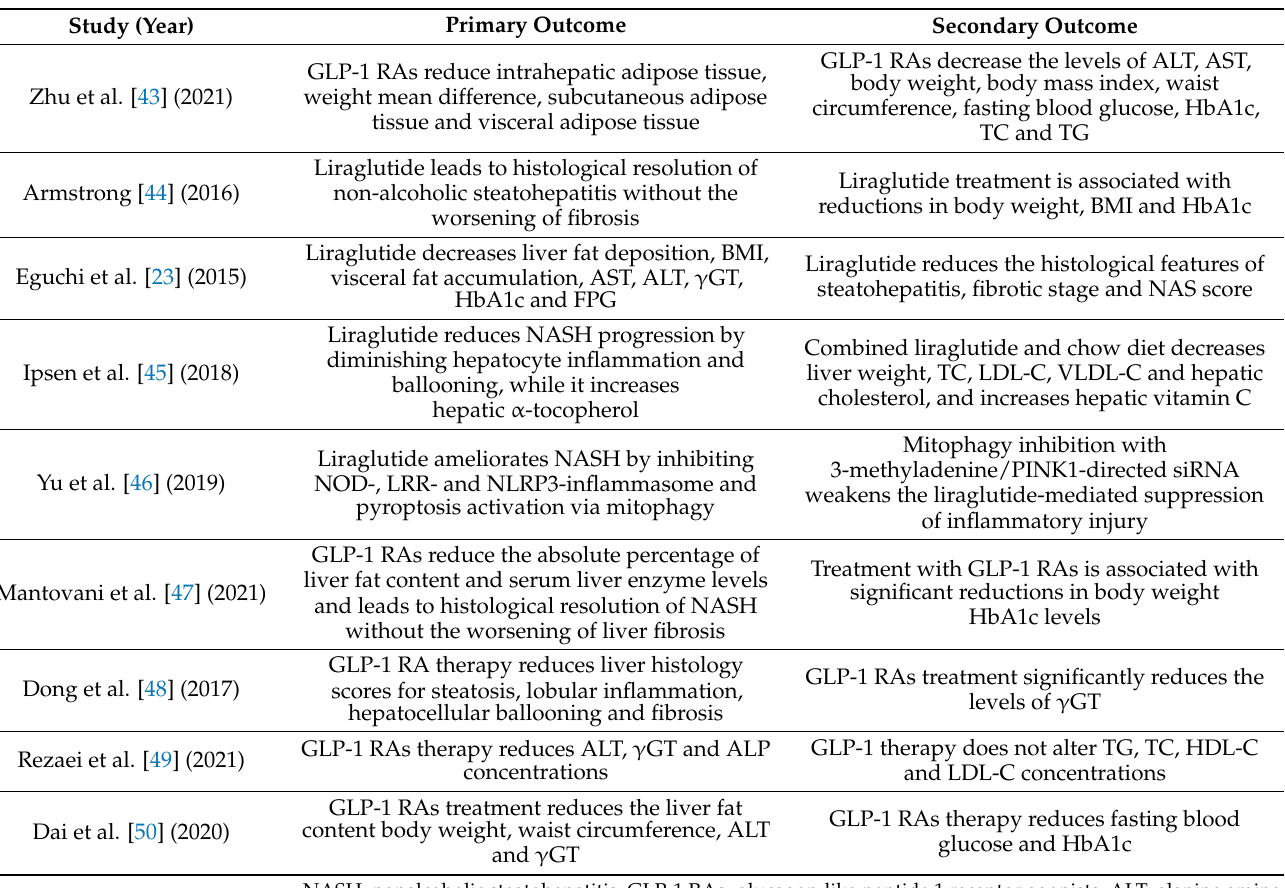
Table 1. Summary of studies evaluating the role of GLP-1RAs in steatohepatitis and